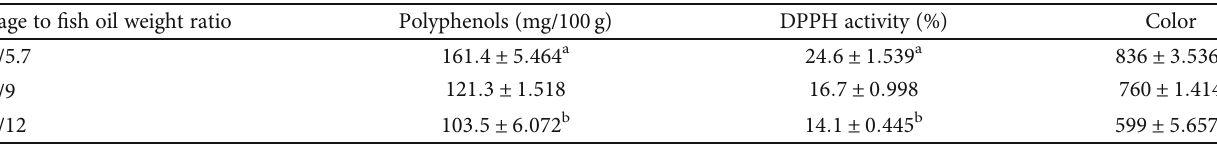
a,b Kruskal-Wallis test: values marked by letter symbols a, b, … , are statistically signi fi cant, p < 0 : 05 (values read in separate columns, marked with the same letter, do not di ff er signi fi cantly; those marked with di ff erent letters di ff er signi fi cantly).